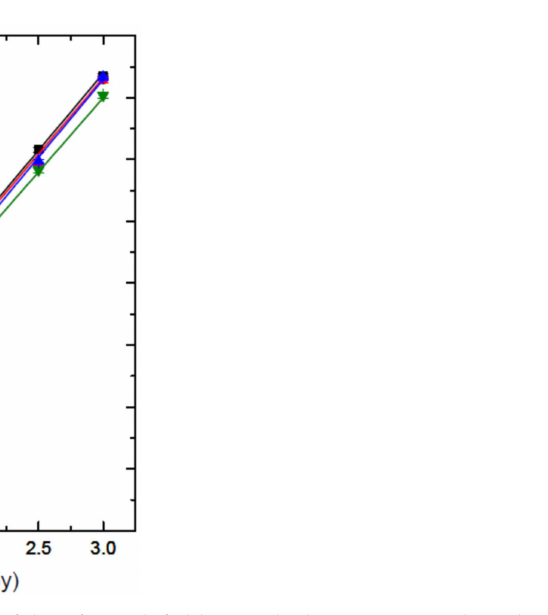
Figure 4. TL response as a function of dose for each field size. The lines correspond to a linear fit. Table 4. Values of the linear fit